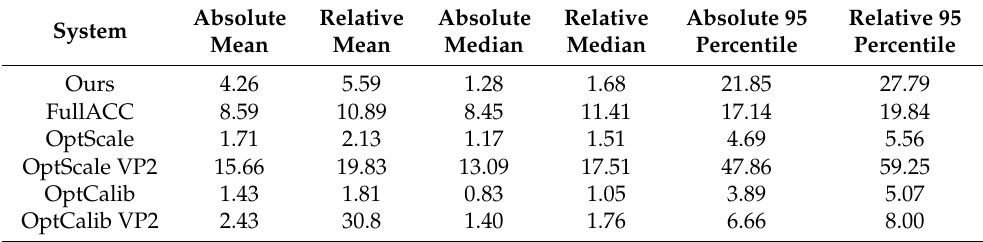
Table 1. The results yielded by the system proposed in this paper are compared to the results obtained in [66]. All data are in kilometres per hour or